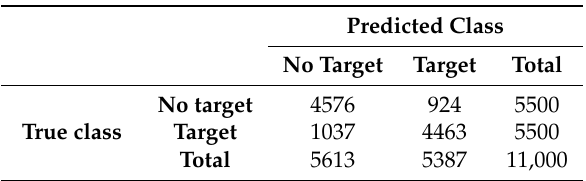
Table 2. Classification table for the model with β of Figure